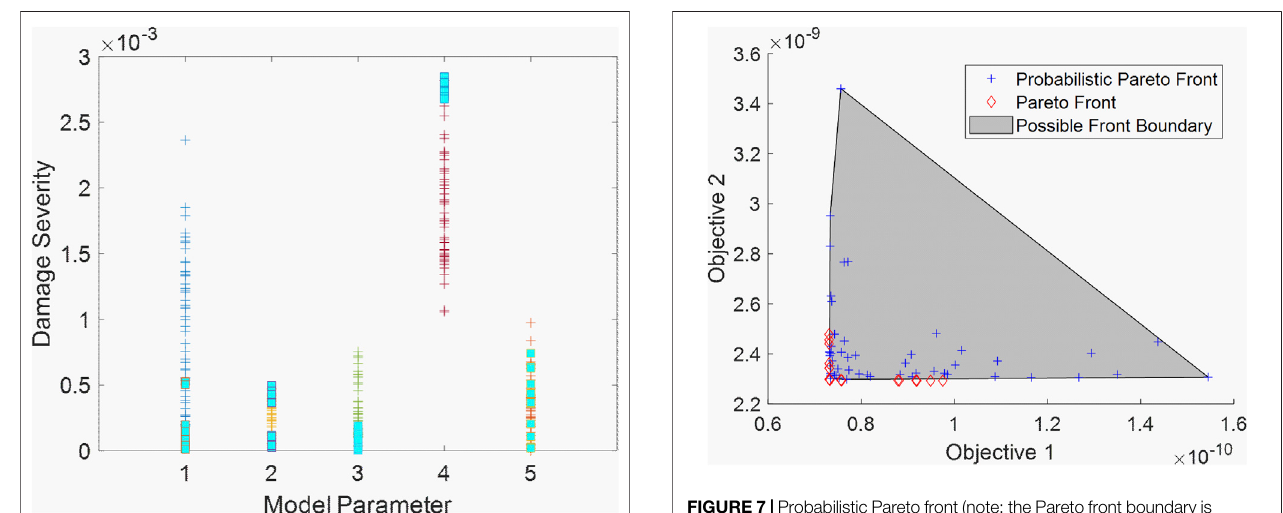
Frontiers in Built Environment |